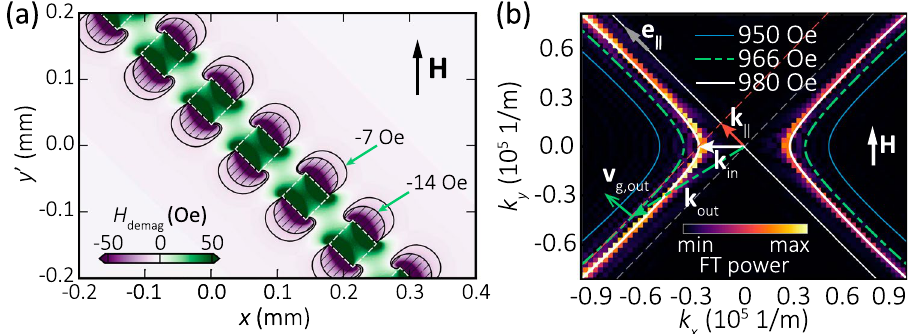
Figure 5. Modeling of spin wave interaction with the antidots line. ( a ) The demagnetizing field in the YIG film (4.5 μ m thickness) near the square antidots row (of 50 μ m size and 50 μ m separation). The colormap shows the demagnetizing field component along the direction of the H oriented at the angle 45° with respect to the antidots line. ( b ) Iso-frequency dispersion relation lines at 4.7 GHz in the homogeneous YIG film for internal magnetic field magnitudes equal 950, 966 and 980 Oe with the thin blue solid lines, dash-dotted green and thick white solid, respectively. The direction of antidots line is marked as e . The wave vector of the incident ∥ and refracted SW is marked with k in and k out , respectively, their component tangential to the line of andidots is k || . The group velocity direction of the refracted SWs is marked with v g,out . In the background by color-map is presented dispersion relation obtained using MS for the field magnitude equal 980 Oe. Perfect matching between simulations results and analytical contour is